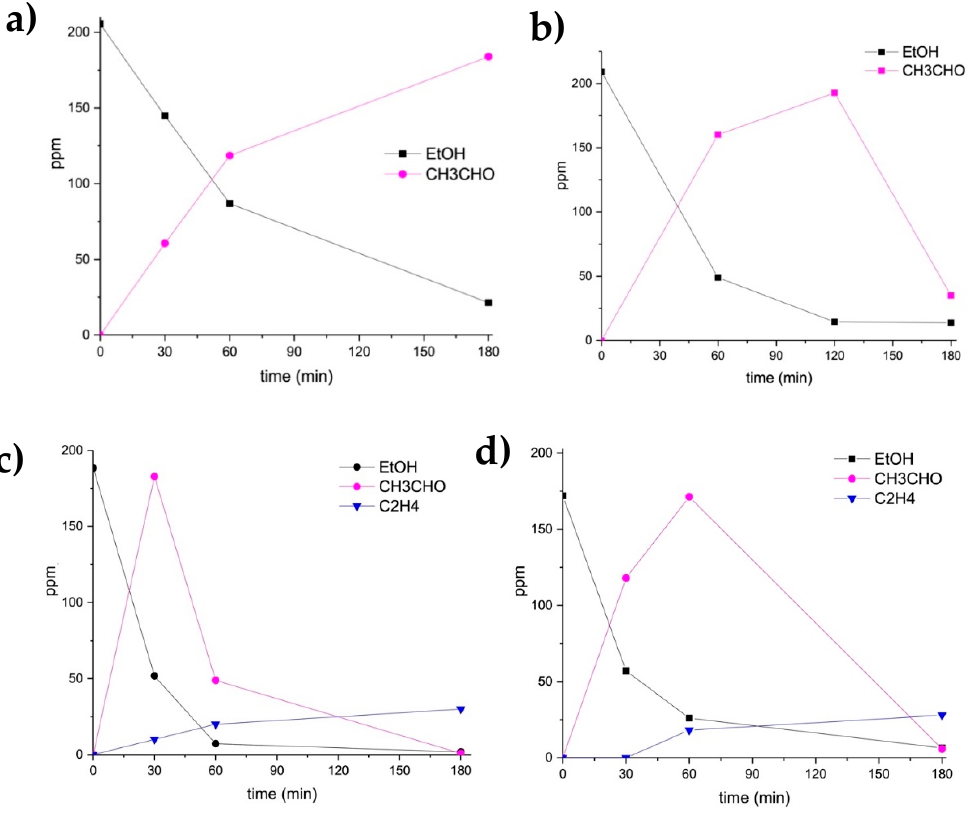
Figure 1. Ethanol photocatalytic degradation by 3%Ag-TiO 2 ( a ), 0.5%Au-TiO 2 ( b ), 0.5%Au/3%Ag-TiO 2 ( c ) and 2%Au/3%Ag-TiO 2 ( d ). Table 1. Ethanol conversion and acetaldehyde conversion after 3 h of UV irradiation. Looking at the photo-oxidation of ethanol using the monometallic 3%Ag-TiO 2 (Figure 1a), ethanol was only partially converted in acetaldehyde, which was the sole detected Sample